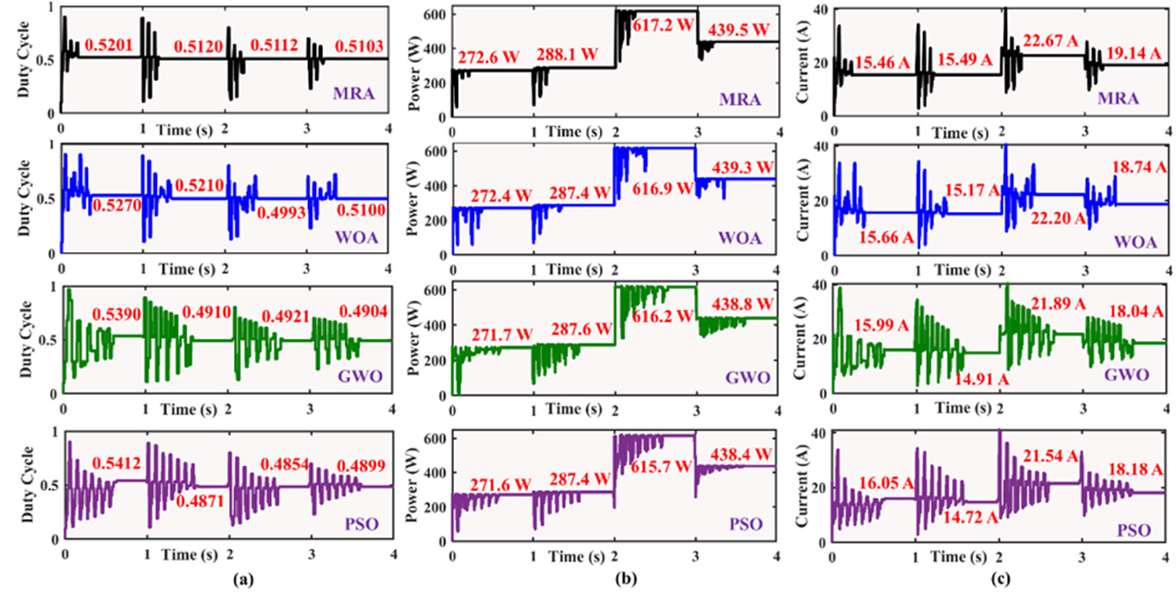
Figure 10. Comparative analysis of all techniques for Case 2 (a) Duty Cycle Variation (b) Power Tracking (c) Current Variation Table 2. Comparative analysis for Case 2.